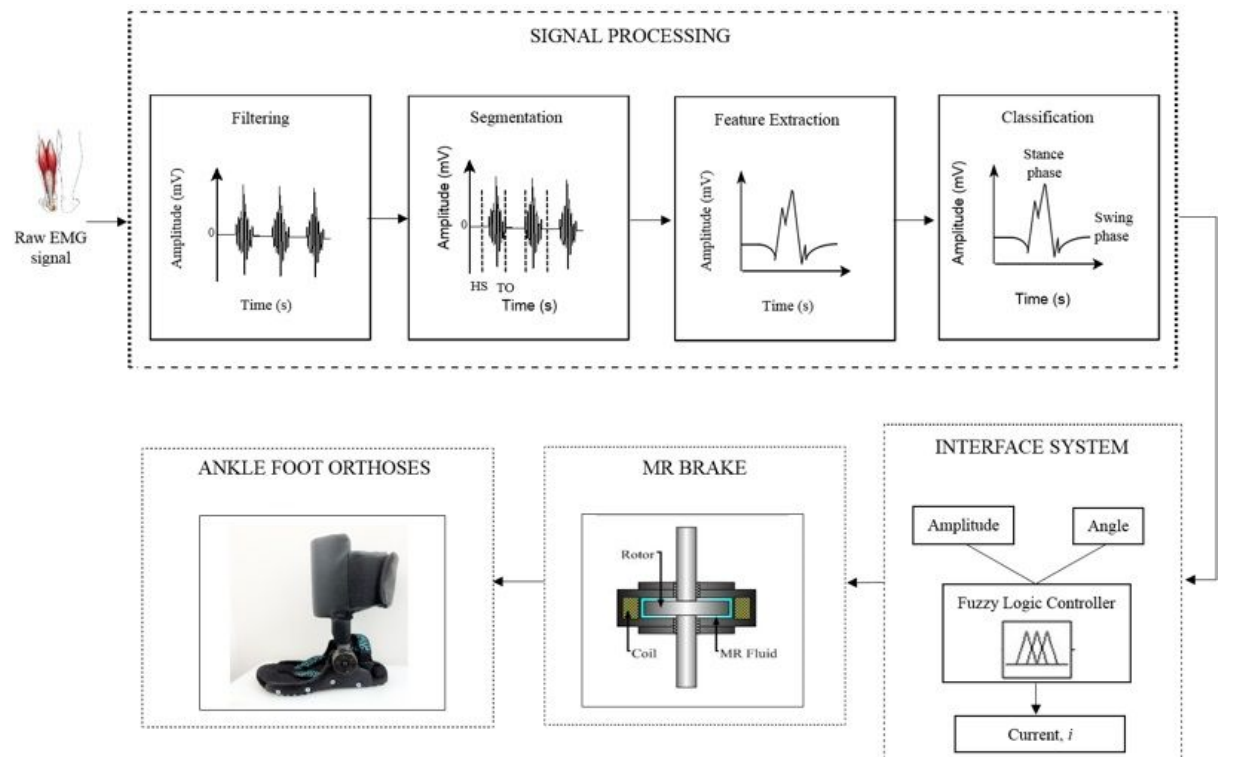
Figure 1: Overview of EMG based control